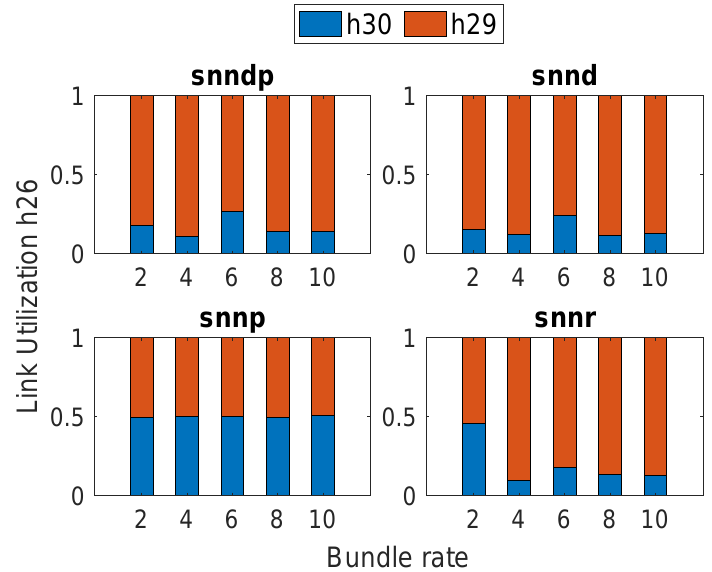
Figure 10. Link selection at Node h26: Scenario 4.